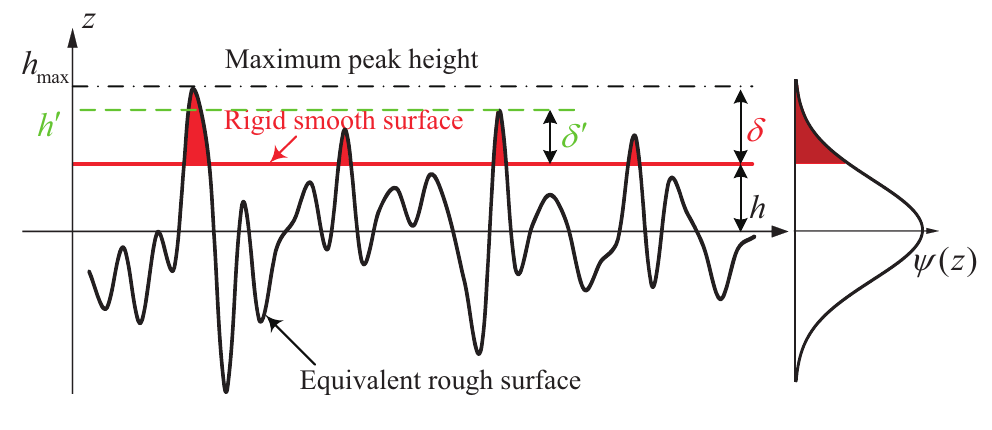
Figure A1. Normal contact of two stochastic rough